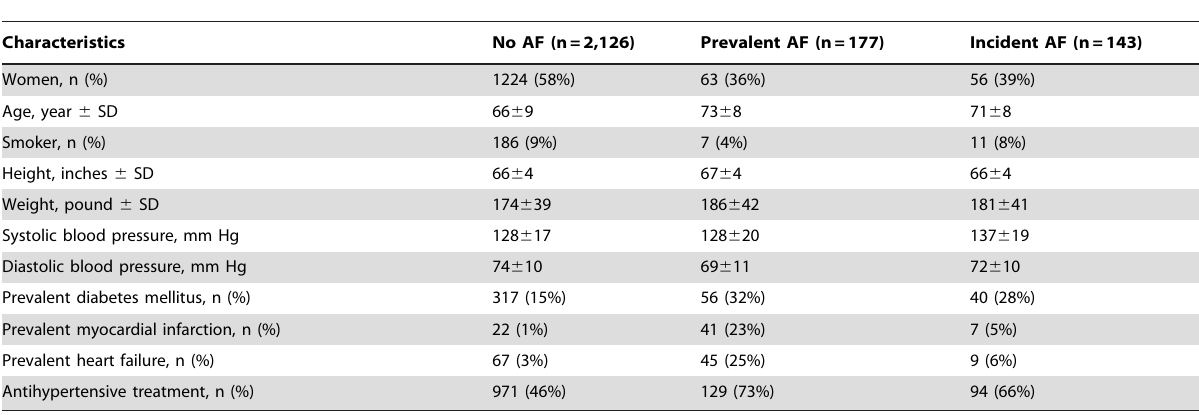
Table 1. Clinical characteristics of the